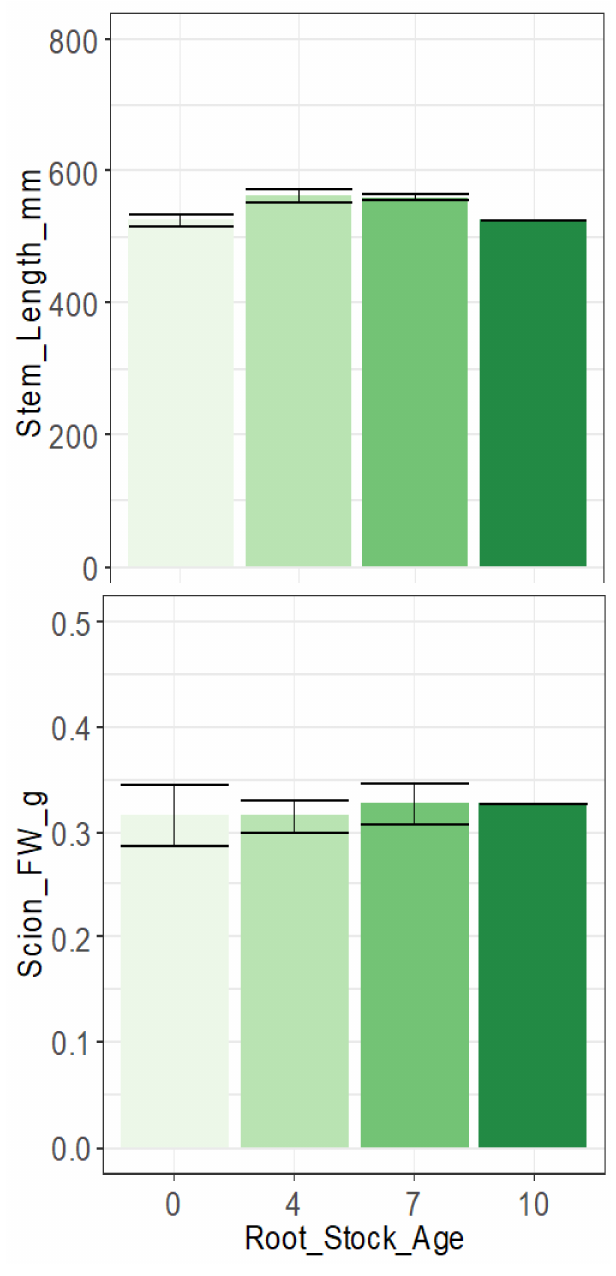
Figure 2. Stem length and scion weight after grafting. N = 5–6 except for 10 day old root stocks in which only 2 survived, so no standard error bar is